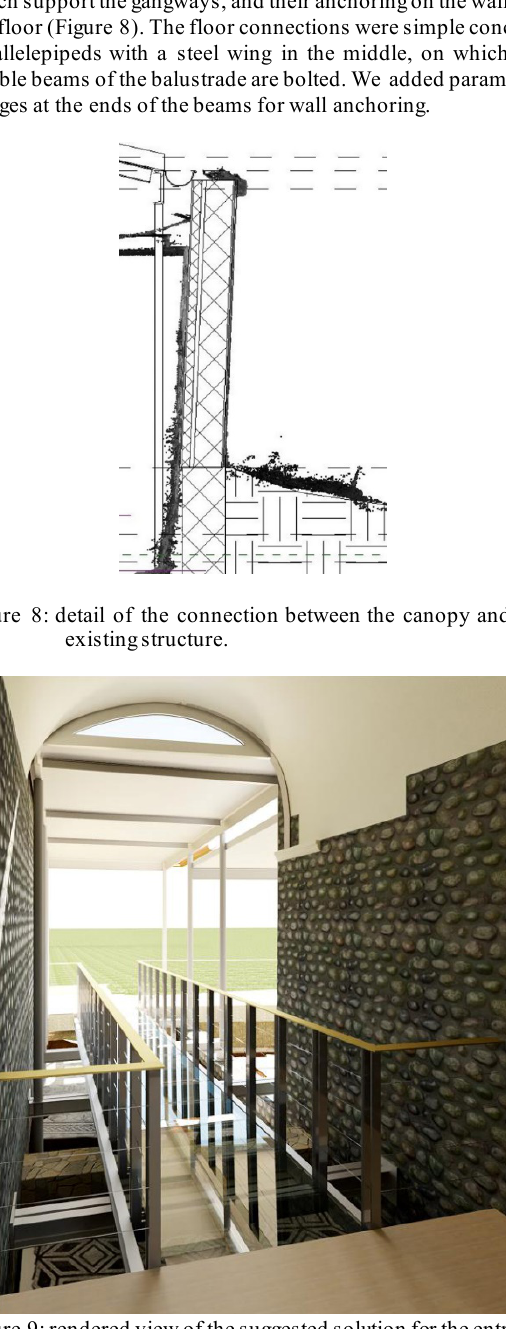
Figure 9: rendered view of the suggested solution for the entrance with the walkway to pass through the mosaics and, at the same time, maintain